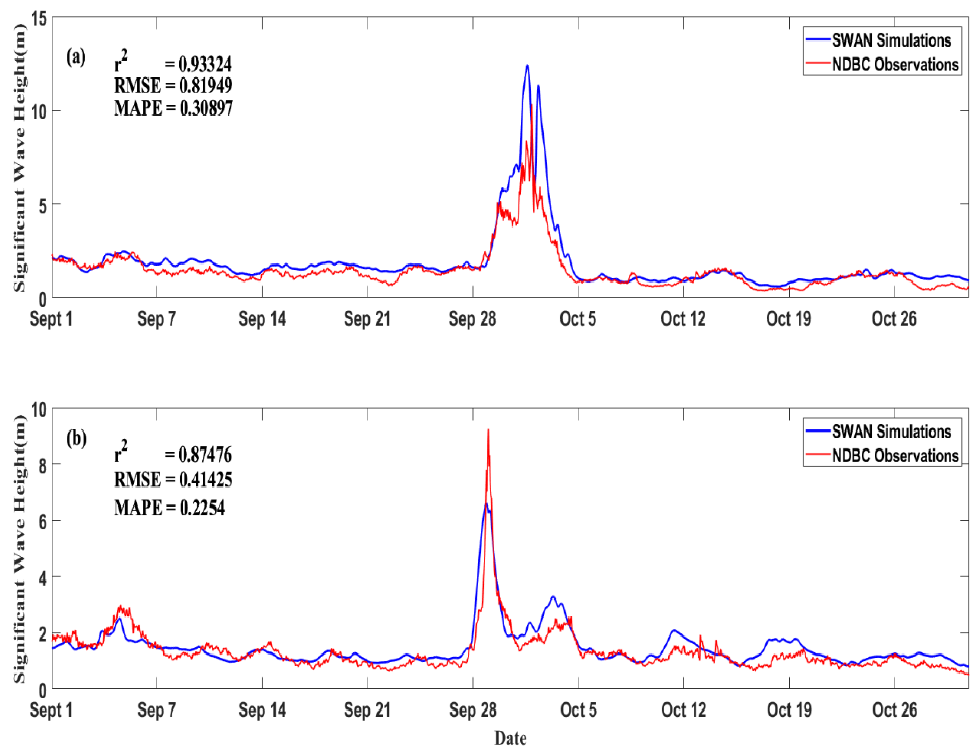
Figure 7. Validation of SWAN-simulated (blue) and NDBC-observed (red) significant wave height for NDBC buoy 42058 ( a ) and 42059 ( b ) before, during, and after the passage of Hurricane Matthew (2016).